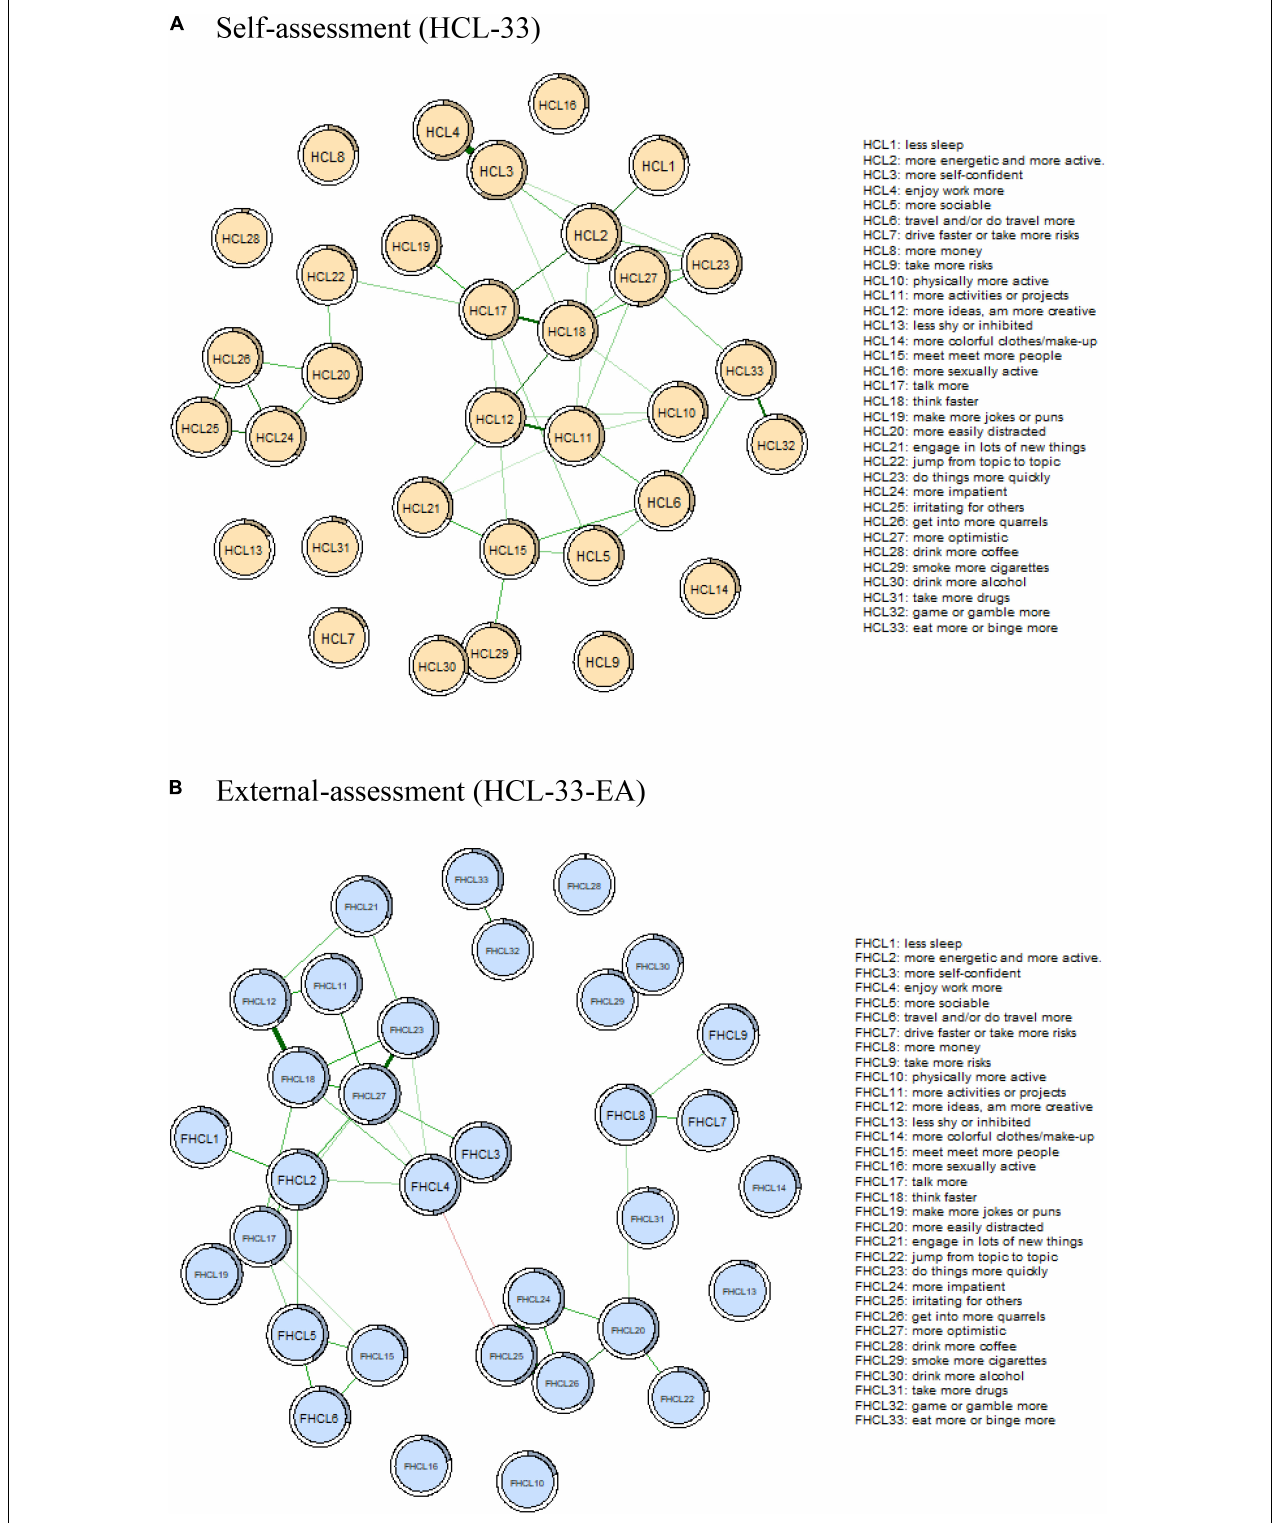
FIGURE 1 | Comparison of network structure between HCL-33 (A) and HCL-33-EA (B) . In this diagram, nodes with stronger correlations are closer to each other. The thickness of an edge indicates the strength of the correlation. Green lines indicate positive associations. Red line indicates negative association. HCL-33, the 33-item Hypomania Checklist (self-assessment version); HCL-33-EA, the 33-item Hypomania Checklist (external assessment version).